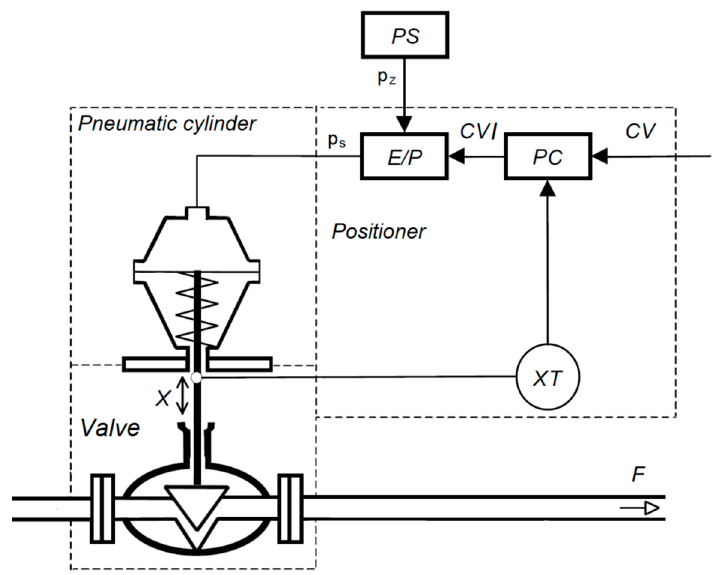
Figure 3. Block diagram of an electro-pneumatic final control element. Notions: CV—output of external controller; CVI—output of internal controller; PC—internal controller; E/P—electro-pneumatic transducer; PS—compressed air supply; p z —supply air pressure; p s —the output pressure of the E/P transducer; X—displacement of the valve plug; and XT—displacement transducer of the actuator’s stem [6].